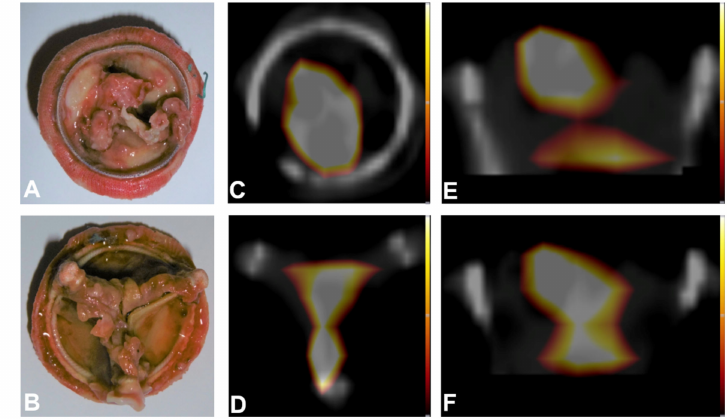
Figure 3. In vitro experiment with explanted bovine pericardial aortic bioprosthesis. ( A ) Bottom view of explanted bioprothesis showing extensive endocarditic vegetation, ( B ) Top view of explanted bioprosthesis, ( C ) Fused PET/CT bottom view, ( D ) Fused PET/CT top view, ( E ) Fused PET/CT, side view, ( F ) Fused PET/CT lateral view. Color bars representing activity concentrations from 1–31,336 Bq/mL.